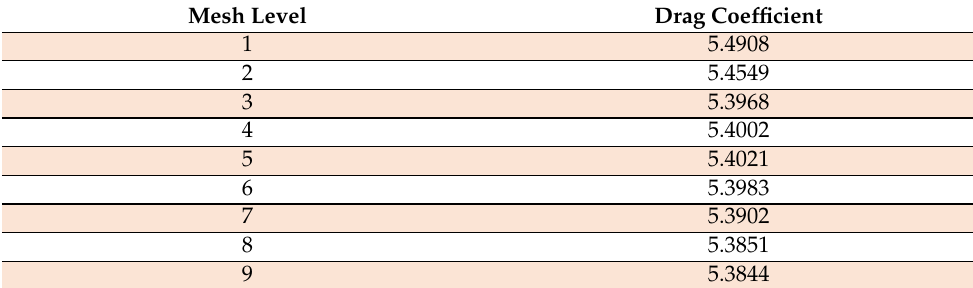
Table 6. Drag coefficient data for Case-III with PVP.